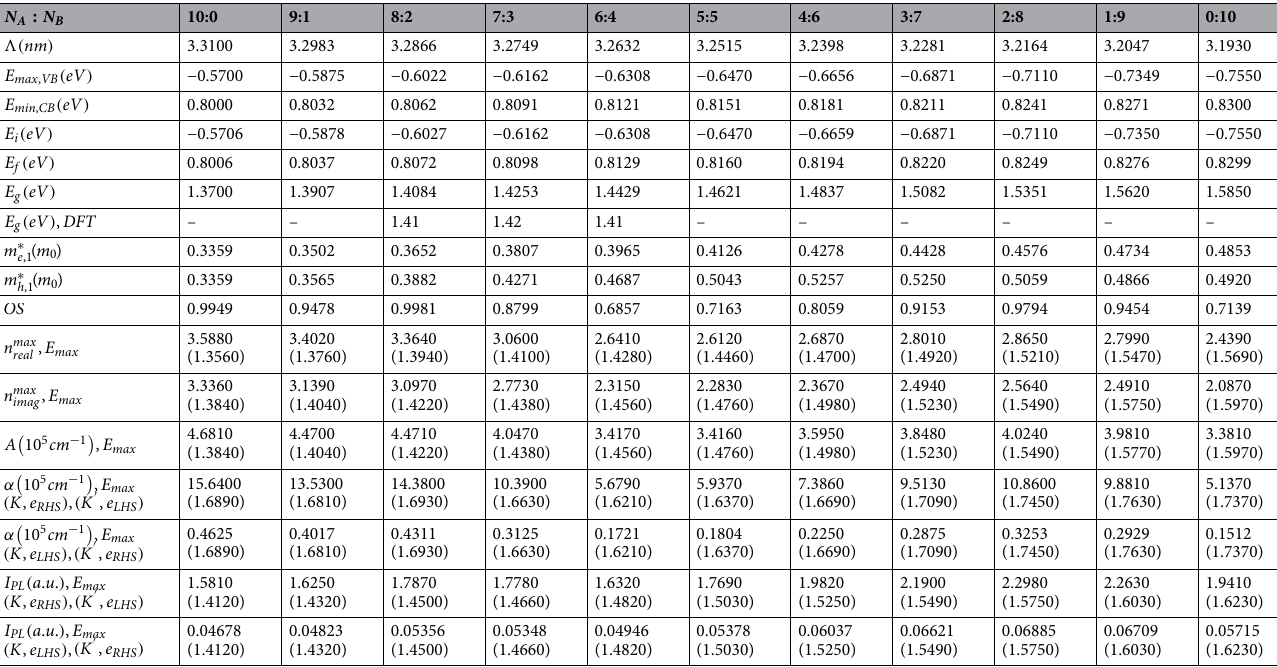
Table 3. Parameters of the electronic and optical characteristics of the TMDC-PSL versus the width ratio of the layers with